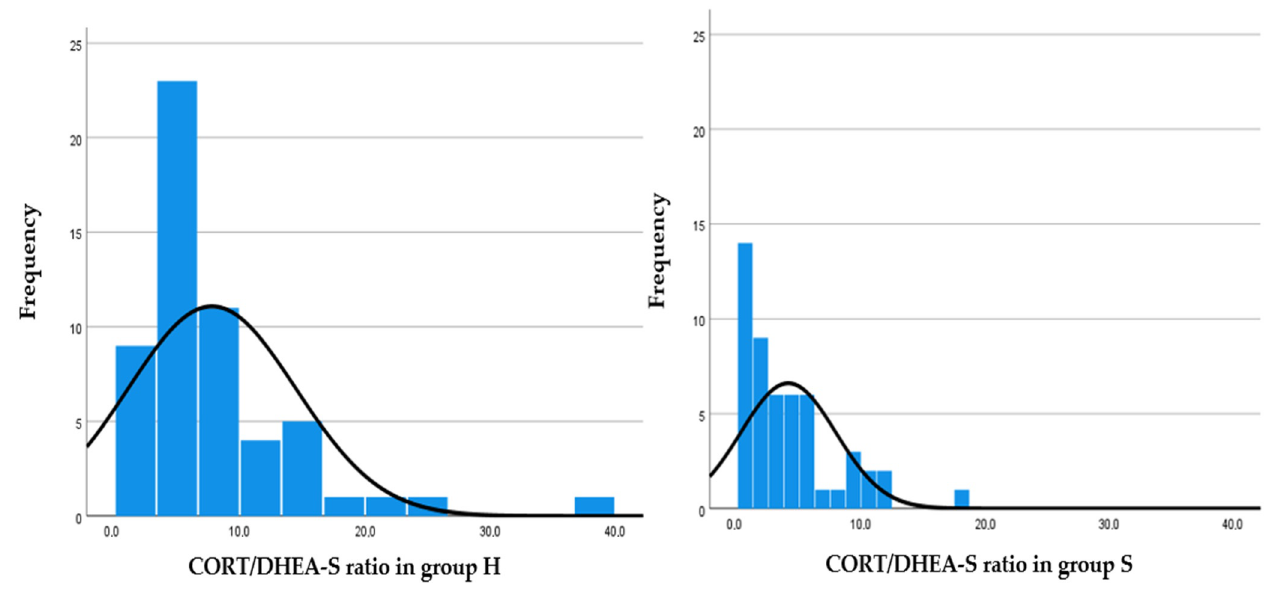
Figure 1. Frequency distribution graphs representing CORT/DHEA-S ratio in healthy (group H; left) and sick (group S; right) foals.